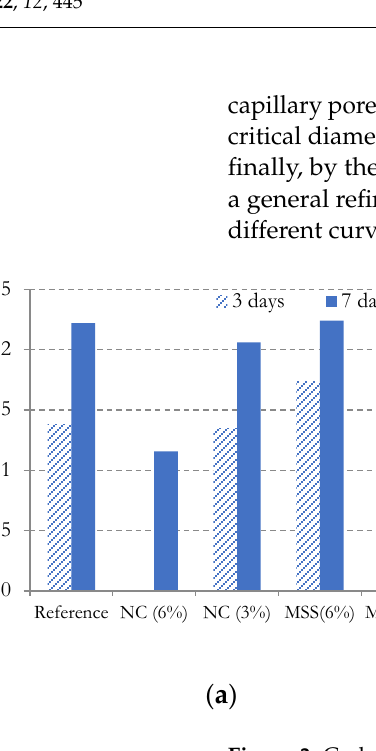
Figure 3. Carbonation depth and chlorides (mm) ( a ) Carbonation ( b ) Chlorides.